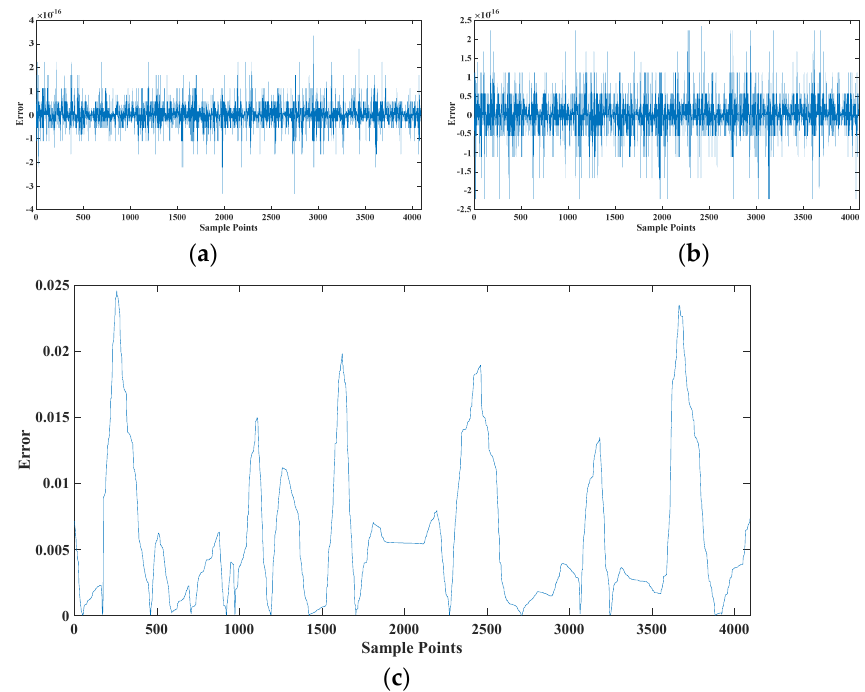
Figure 11. Comparison of the reconstruction errors of three methods: CEEMDAN, ICEITDAN, and ITD. ( a ) CEEMDAN, ( b ) ICEITDAN, and ( c ) ITD. Table 6. Comparison indicators for the three methods.